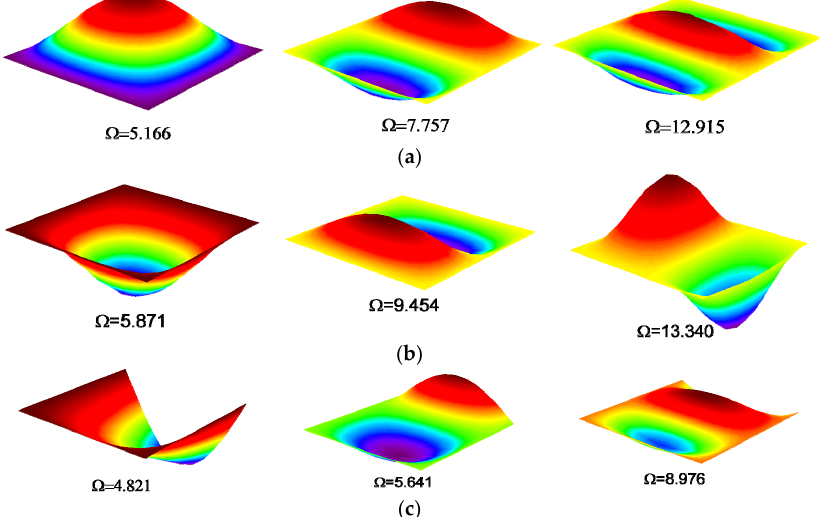
Figure 9. The first three modes for square laminates (0°, 90°, 0°) with h/b = 0.1: ( a ) SSSS; ( b ) SCSC; ( c ) SSSF.